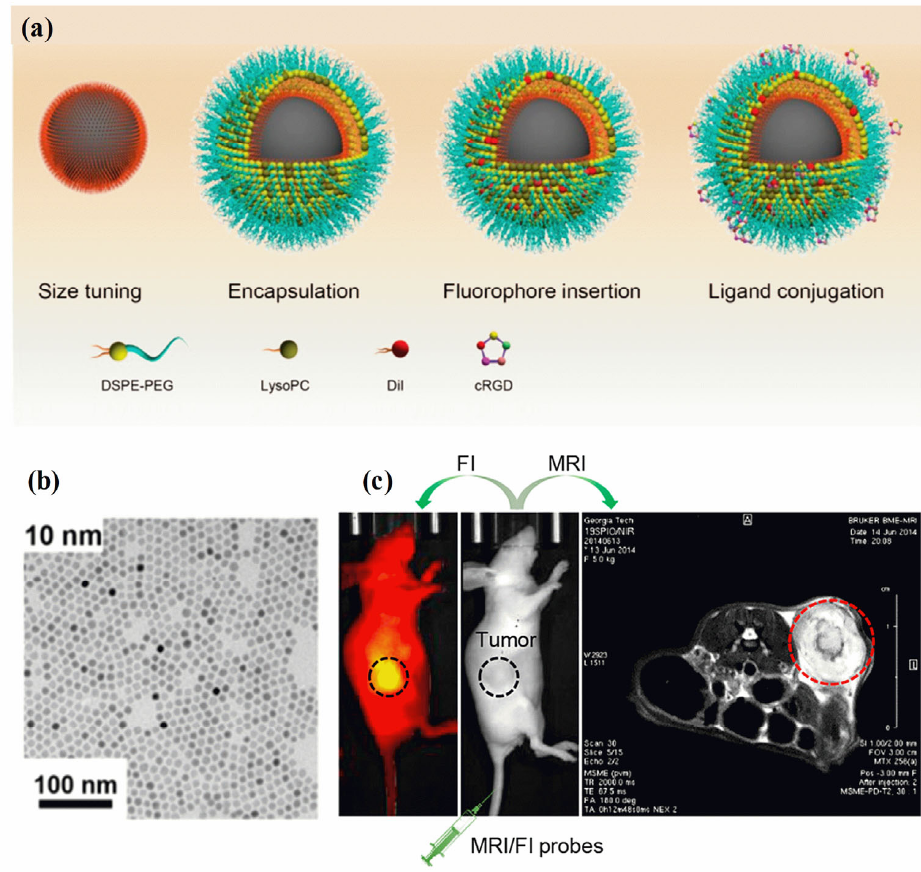
Figure 5. ( a ) Schematic diagram of MRI/FI nanoprobes using Fe 3 O 4 NPs, ( b ) TEM image of Fe 3 O 4 NPs, and ( c ) the use of MRI/FI nanoprobes for imaging tumor-bearing mice. Reprinted from Ref.